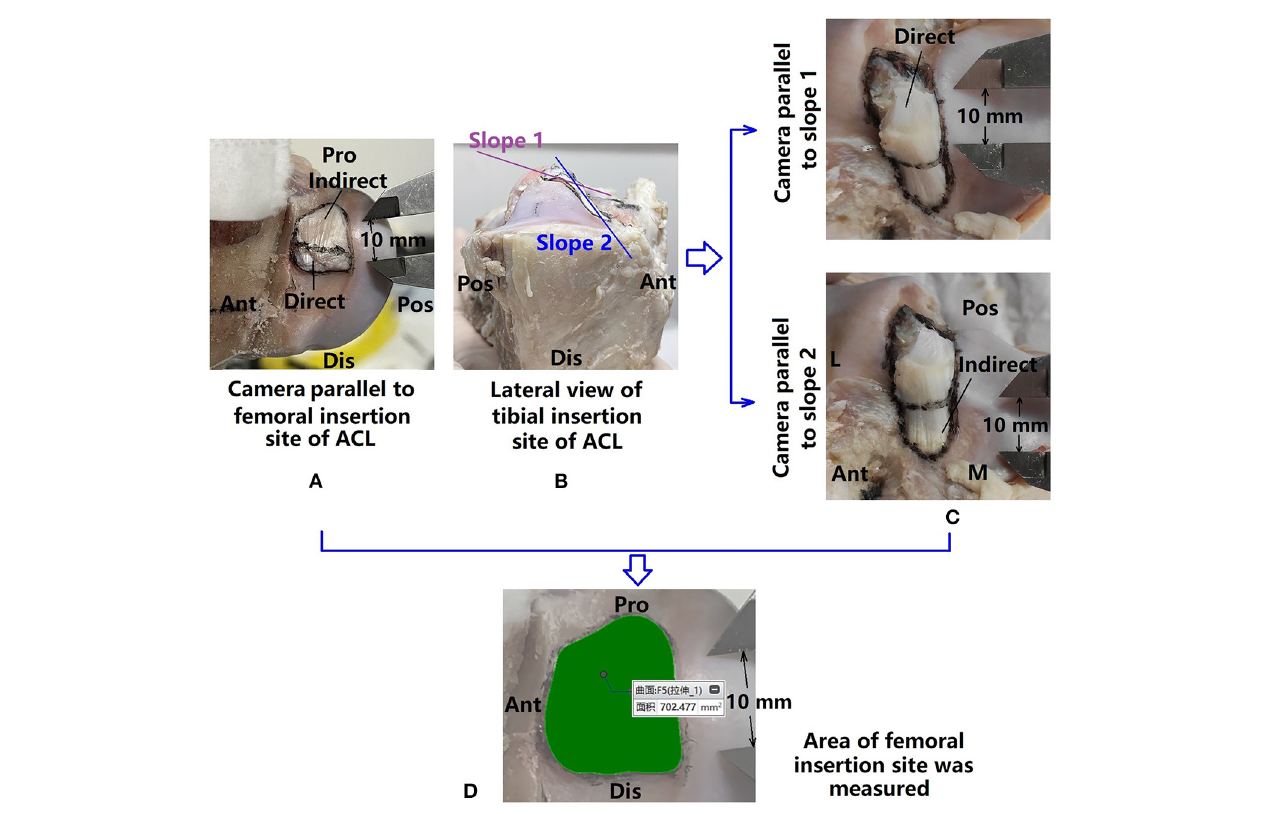
FIGURE4 Measuring areas of ACL bone insertion sites. (A) Femoral insertion site marked and photographed; (B) tibial insertion site showing double-sloped shape, and thus (C) the tibial insertion site was photographed twice with the camera parallel to each slope; (D) marked areas were measured with a precision of 0.001mm.